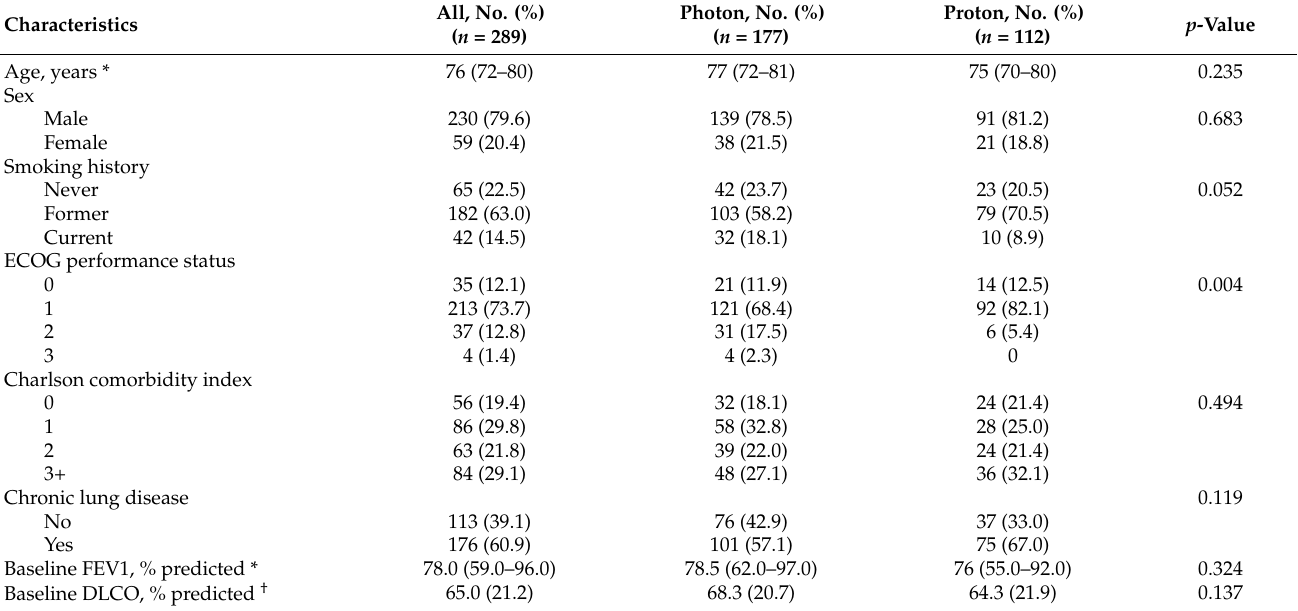
Table 1. Patients’ characteristics.